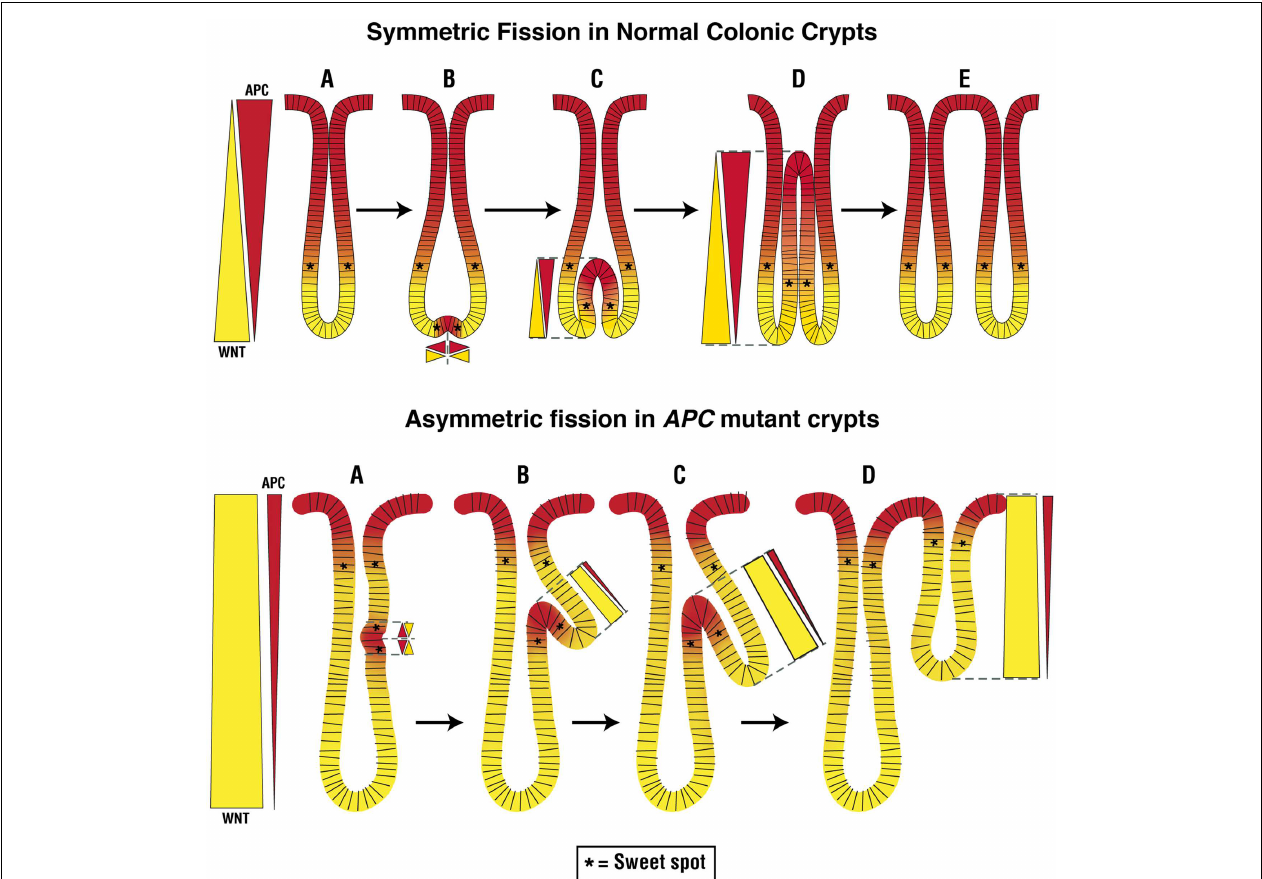
counter-current-like gradients of APC andWNT.The optimal conditions that support the high rate of proliferation in the new sweet spots provide the mechanism for a high rate of cell proliferation that expands the colonocyte population which drives the growth of the bifurcation upwards.The lower panel in the figure depicts the abnormal crypt cycle. In crypts with mutant APC, the rate of crypt fission is increased and fission often occurs asymmetrically. In this case, fissioning occurs because the budding/bifurcation starts somewhere along the crypt axis but not at the crypt bottom. Consequently, creation of two new counter-current like gradients of APC andWNT along the crypt column leads to generation of two new sweet spots which drive growth of the bifurcation upwards in an asymmetric fashion. The result of this abnormal crypt fission is two crypts of different